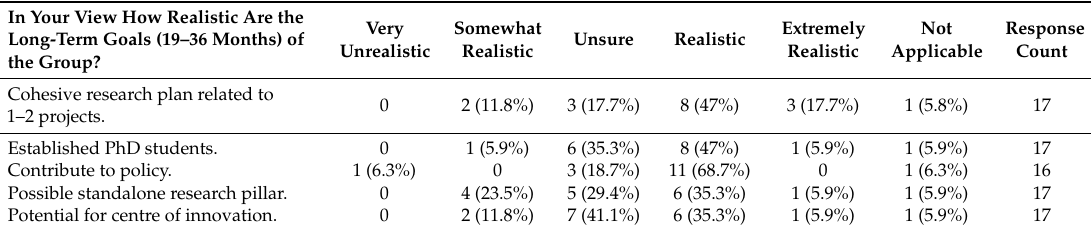
Table 5. The extent to which SIG members agree that the long-term goals (19–36 months) of the group are